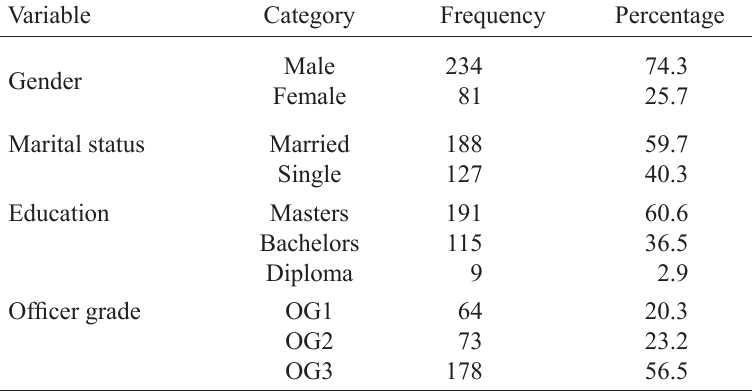
Demographic Profiles of